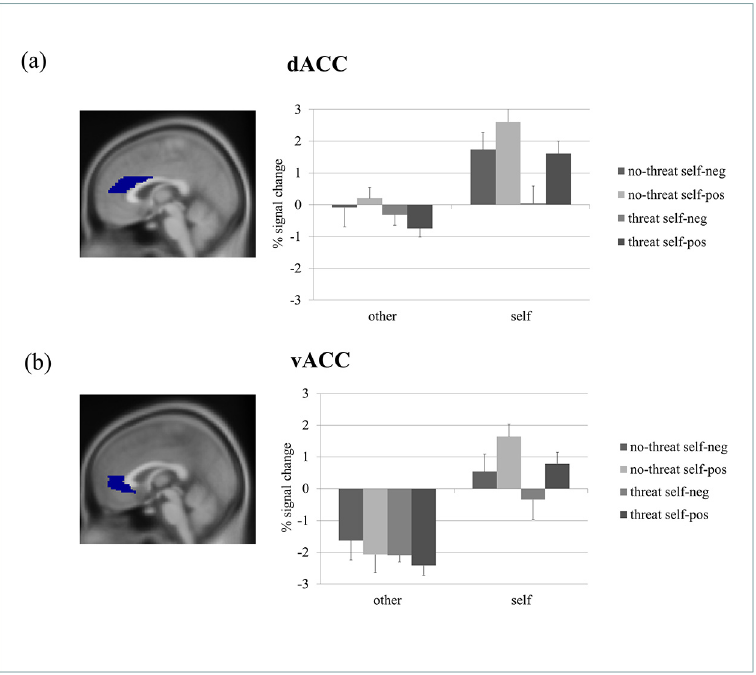
Fig 5. ROI-analyses: Averaged percent signal change values for all conditions against baseline shown for a) the dorsal anterior cingulate cortex and b) the ventral anterior cingulate cortex.